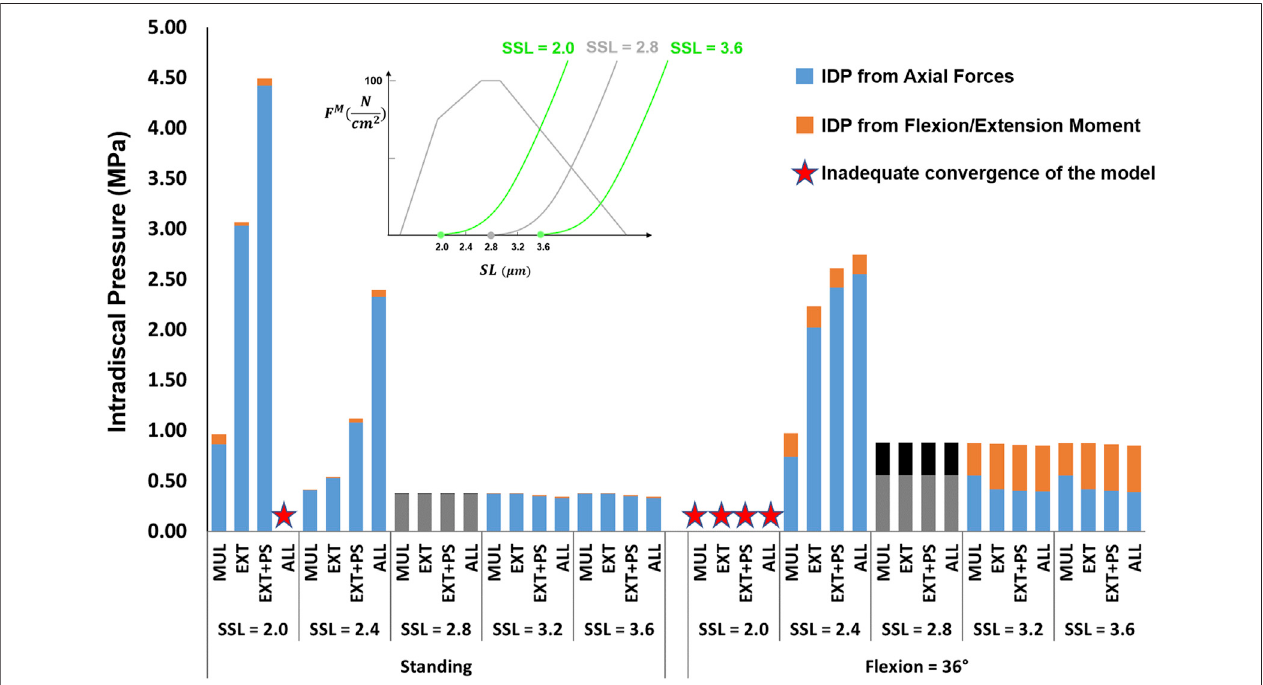
FIGURE 5 | The effect of different slack sarcomere length (SSL) values on L4-L5 IDP in upright standing and 36 ° fl exion for four scenarios: changes applied to multi fi dus (MUL), extensor muscles (EXT), extensor muscles, and psoas (EXT + PS), and all 210 muscles in the model (ALL). Grey/black bars represent the baseline